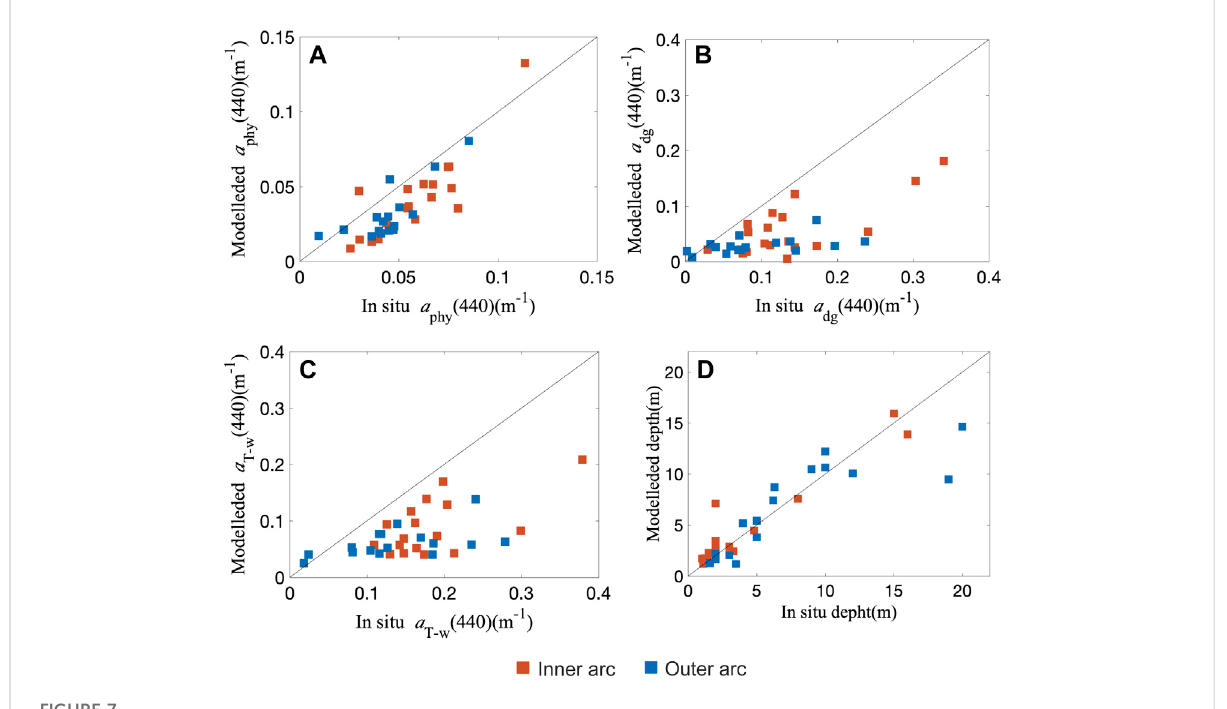
FIGURE 7 Comparison between in situ measured a phy , a dg , a T-w and depth versus HOPE model retrievals performed on the in situ R rs ( λ ) spectra. (A) a a a phy (440). (B) dg (440). (C) T-w (440). (D) depth. Red squaresrepresent the18 samples of theinner arc, and blue squares represent the16 samples of the outer arc. The diagonal lines represent the linear regression fi